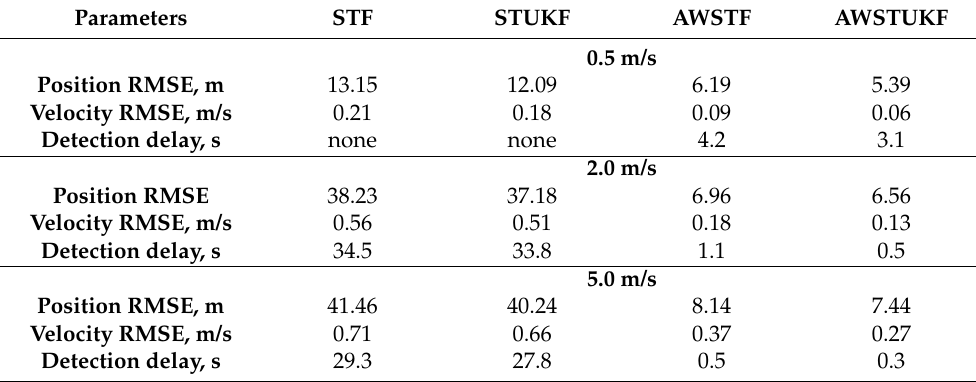
Table 1. Tracking performance of different methods in different